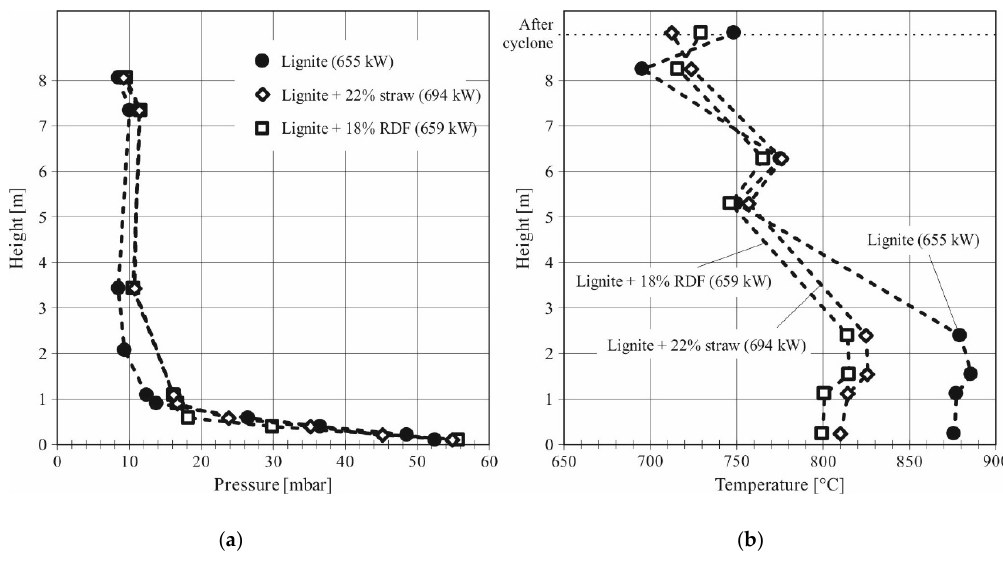
Figure 4. Pressure-profiles ( a ) and Temperature-profiles ( b ).